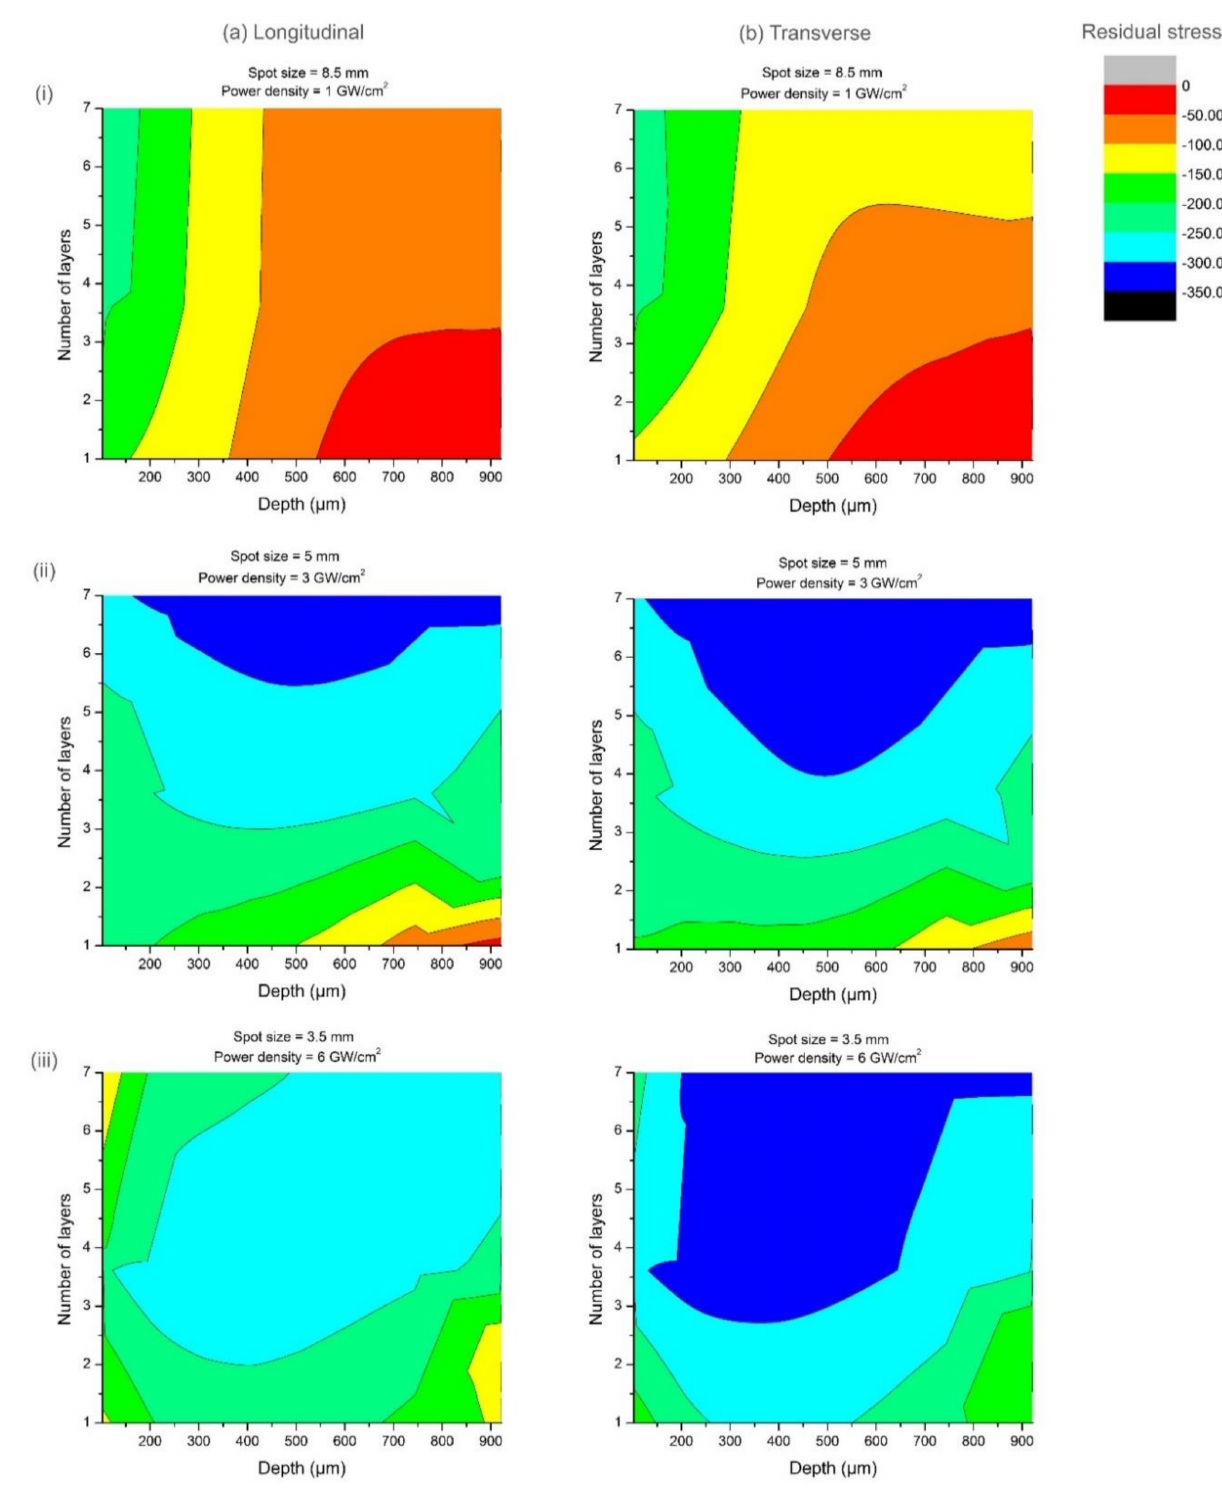
Figure 9. Parametric studies showing the variation of residual stresses as a function of input number of layers for different spot size and power density combinations in single-shot laser peening data (dataset